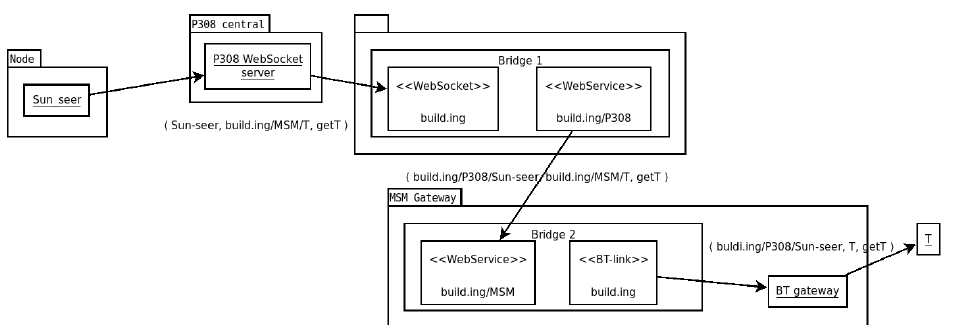
Figure 5. An illustration of the path taken by a message while crossing multiple communica- tion